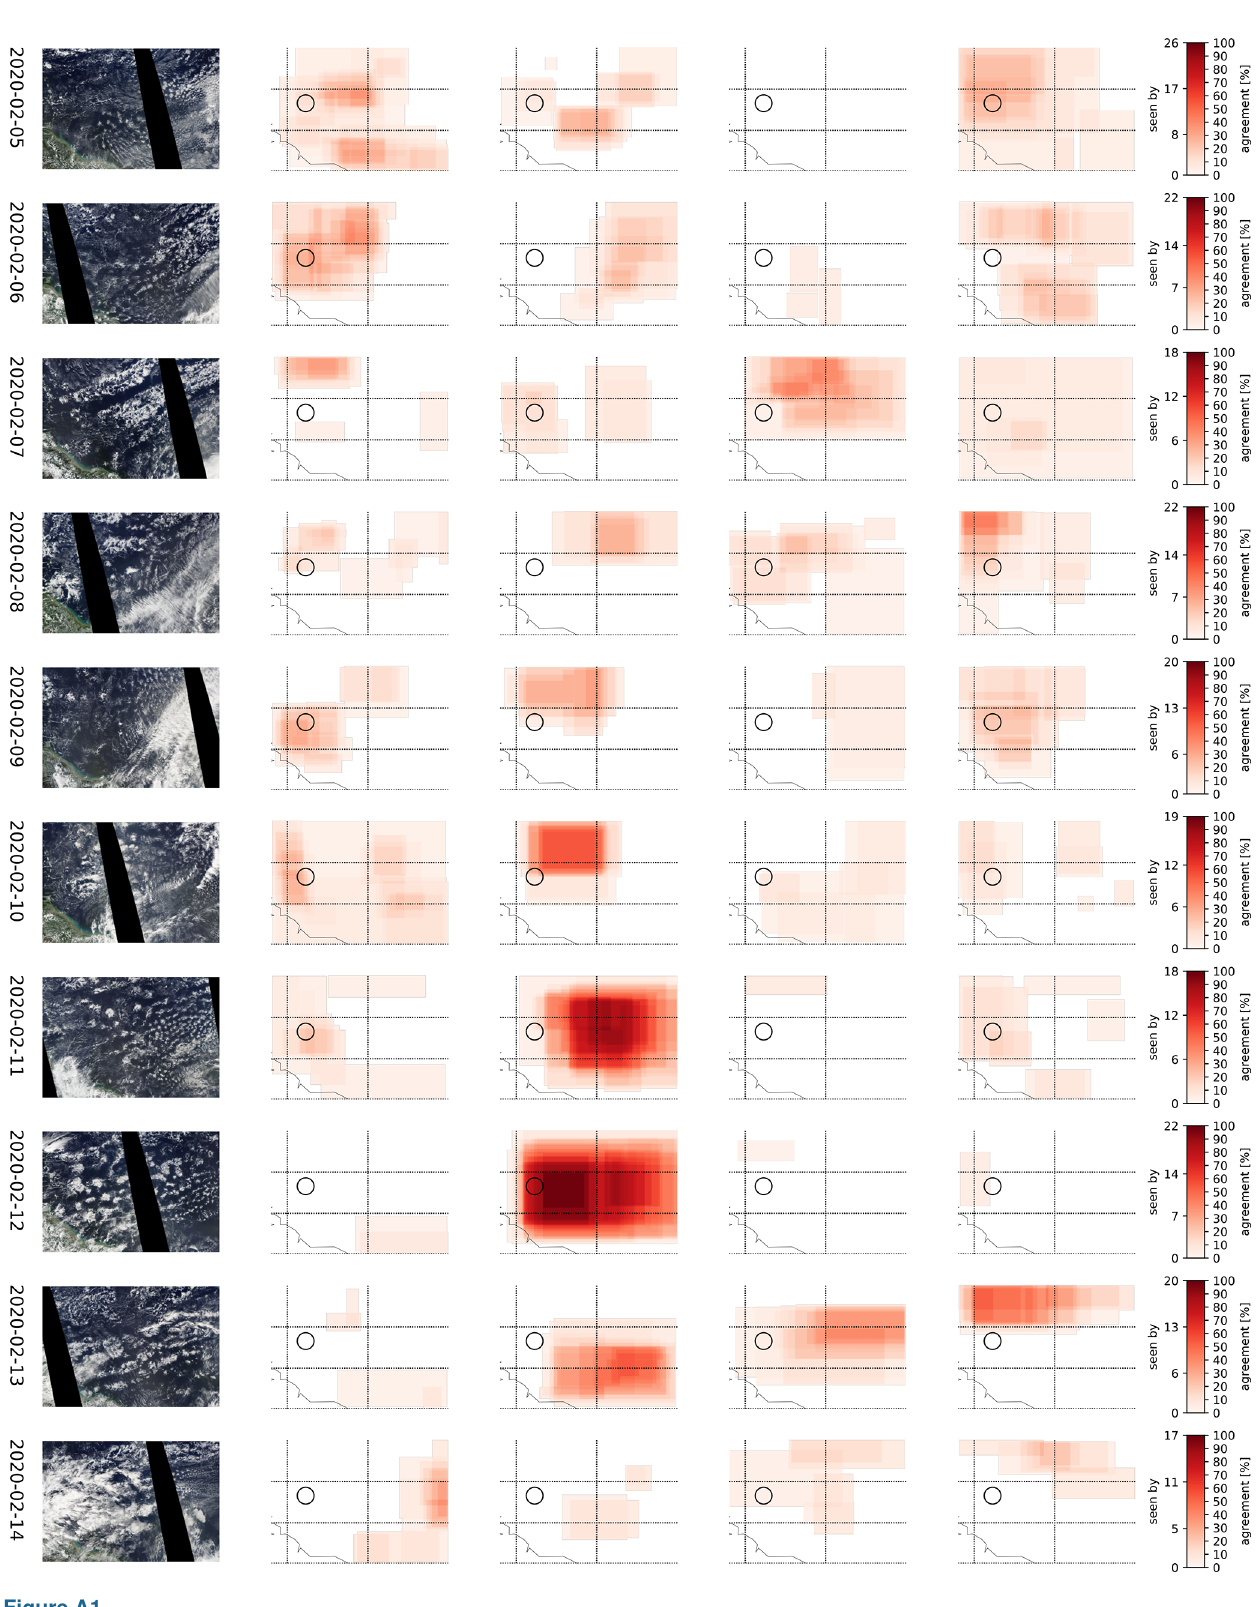
Earth Syst. Sci. Data, 14, 1233–1256,